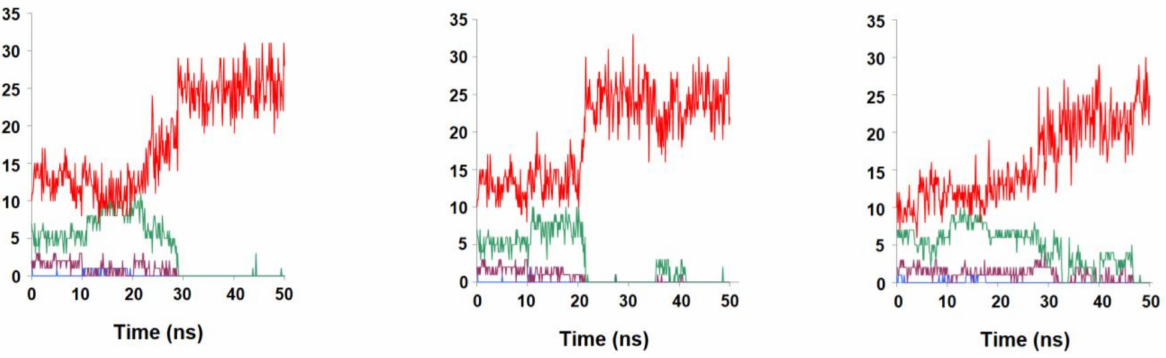
Figure 2. Evolution of contacts between the dihydropterin core (molecule 1 ) and R67 DHFR along multiple simulations. red: number water molecules < 3 Å from the ligand; green: number of aminoacid residues < 3 Å from the ligand; violet: number of H-bonds between protein surface and the ligand; blue: number of H-bonds between NADPH and the ligand.